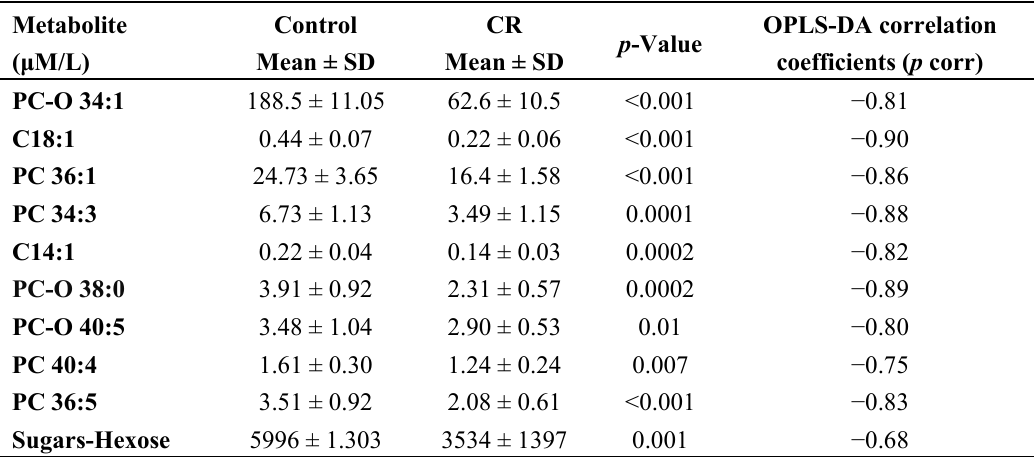
Table 3. Top 10 most discriminating metabolites in blood serum (mean values ± SD) from the targeted MS on the C57BL6/J strain. Significant differences were assessed by Mann-Whitney U